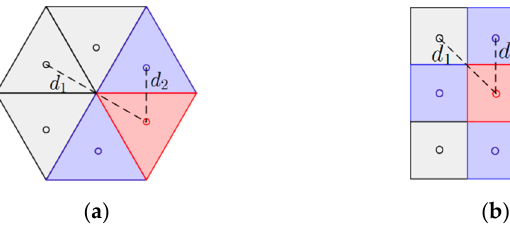
Figure 3. The neighboring relationship for different cell types: ( a ) triangles; ( b ) quads; ( c ) hexagons. d 1 and d 2 are distances between two neighboring cells (source—own study).